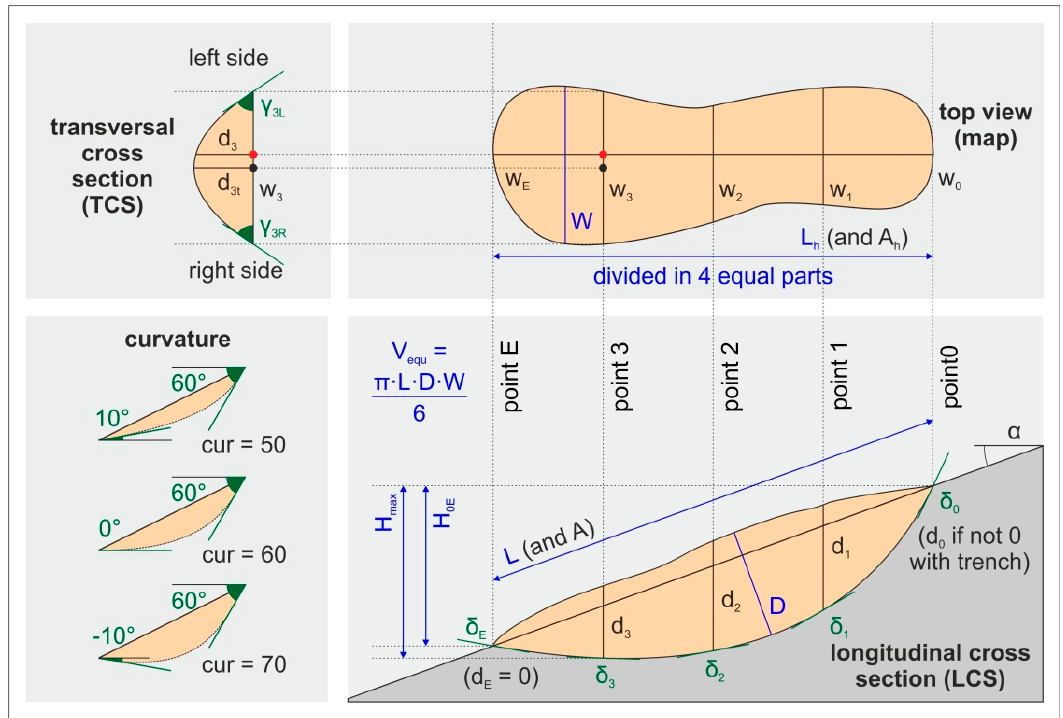
Figure 4. Description of parameters defining a landslide rupture zone (adapted and further developed from the IAEG Commission on Landslides [33]).